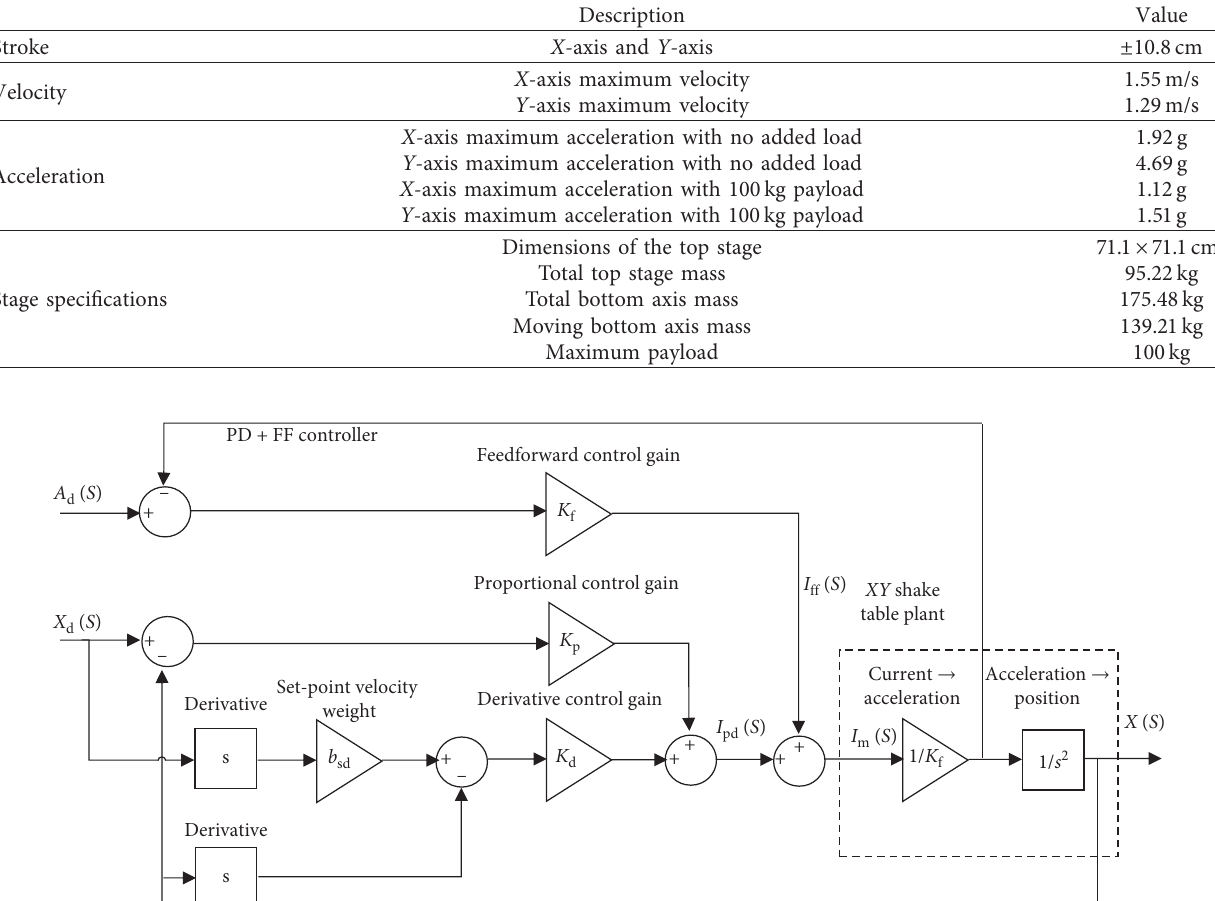
Table 1: Specifications of QUANSER STIII.